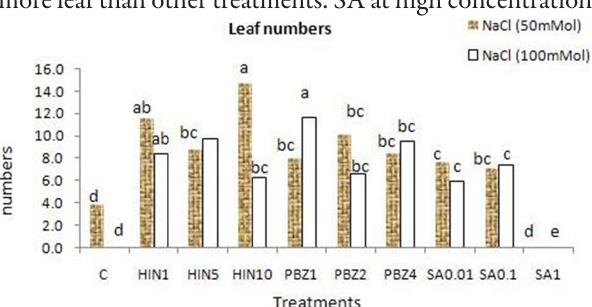
Fig. 1. Effect of hinokitiol, salicylic scid and paclobutrazol on leaf number Note: Numbers beside the abbreviations indicating the tested concentrations of